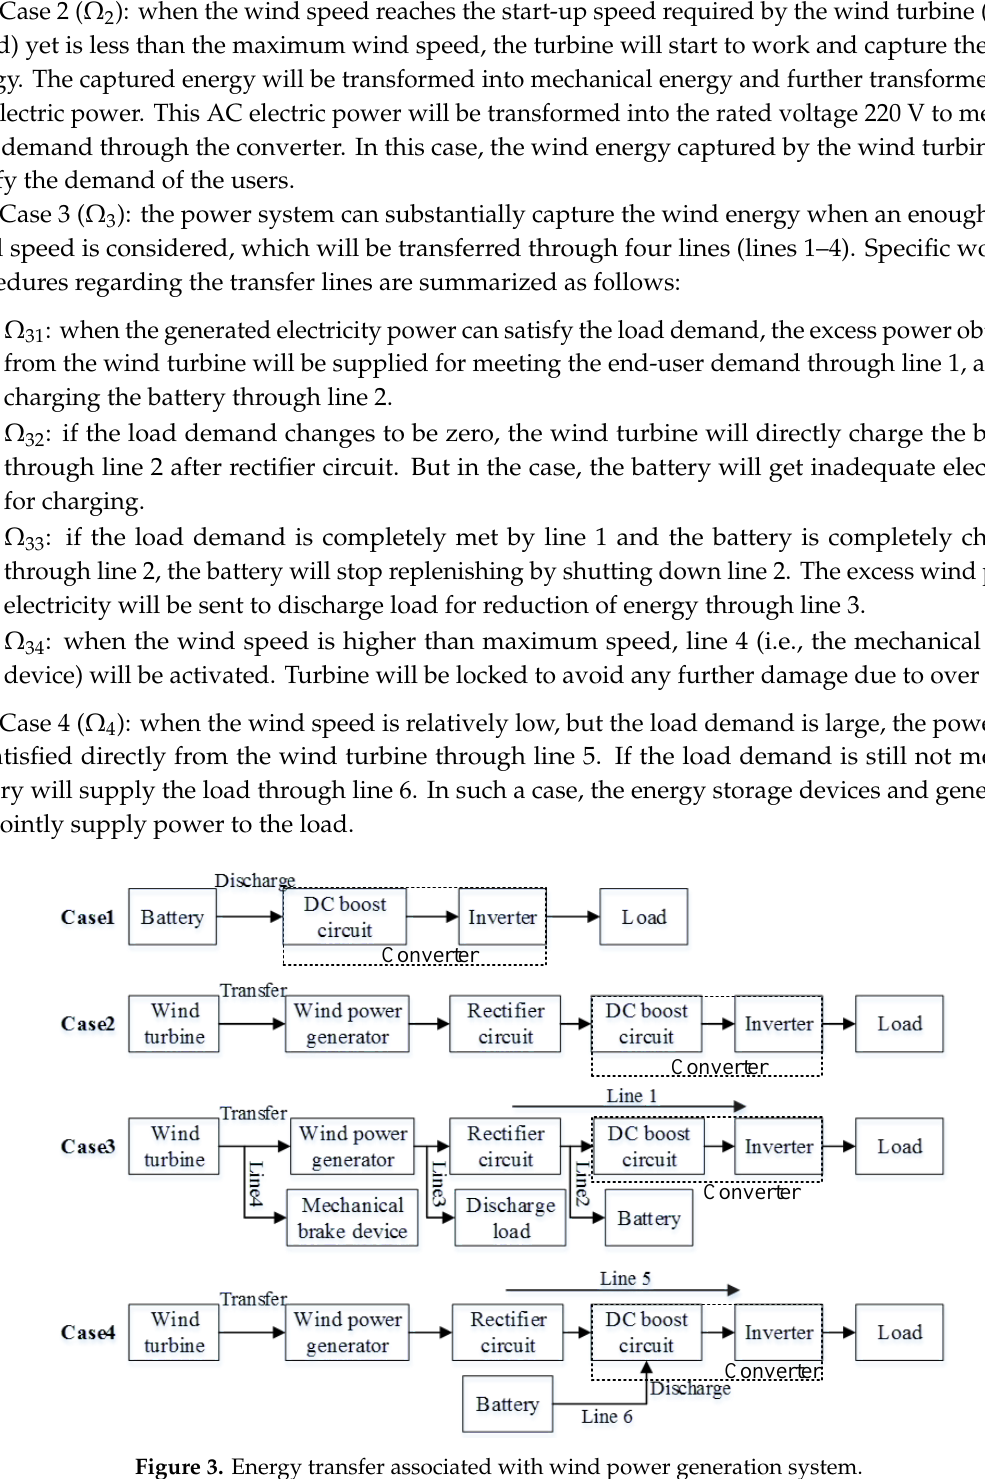
Figure 3. Energy transfer associated with wind power generation system.